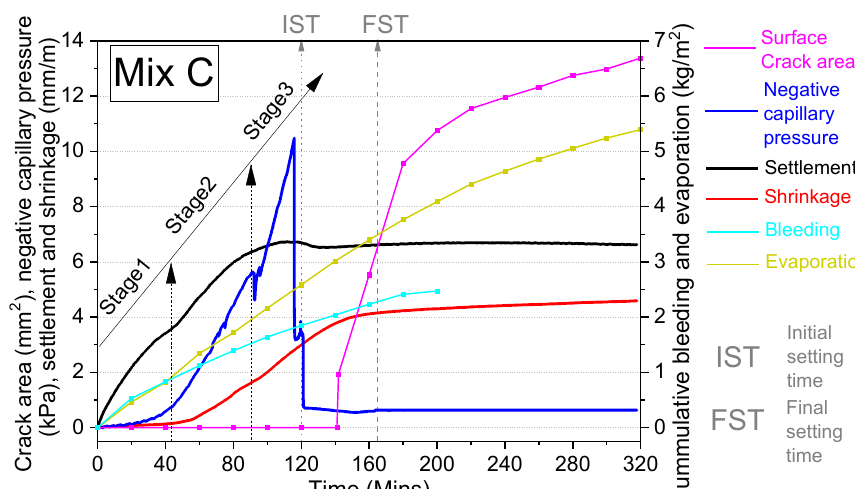
Figure 11. Plastic cracking behaviour of mix C.